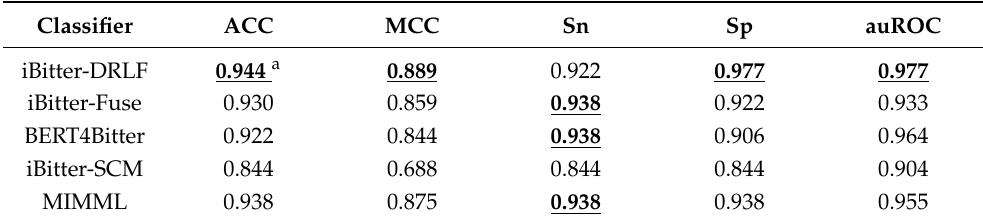
Table 4. Comparison of performance metrics of bitterness prediction using iBitter-DRLF and alter- native state-of-the-art methods while testing independent samples.